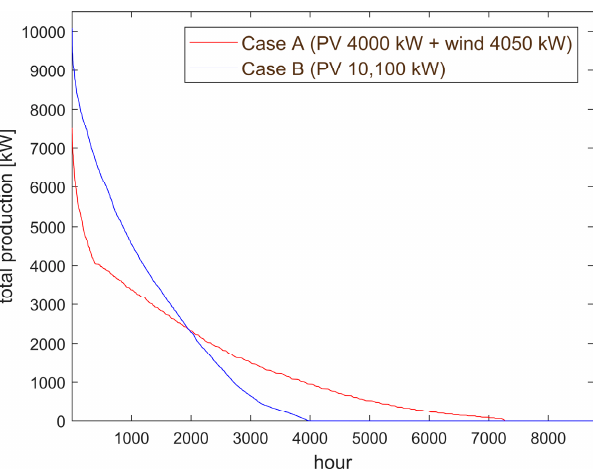
Figure 5. Comparison of production duration curves in Case A and Case B.